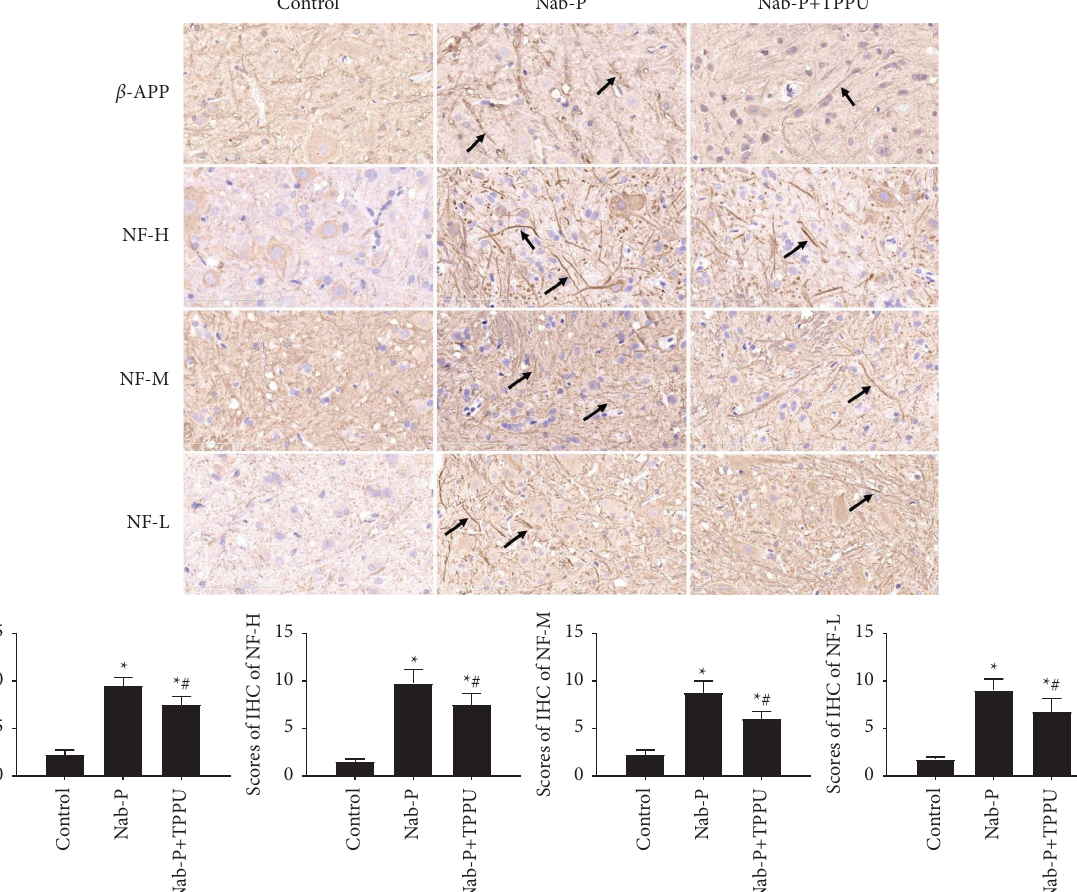
Figure 2: Inhibition of sEH-protected axons from nab-paclitaxel treatment. Pathological changes in axons were evaluated by immu- nohistochemistry of NF-L, NF-M, NF-H, and β -APP. Scale bars � 100 μ m. n � 6; ∗ P < 0 . 05 compared to the control group, # P < 0 . 05 compared to the nab-P group. Black arrows indicate the NF-L, NF-M, NF-H, and β -APP positive cells,